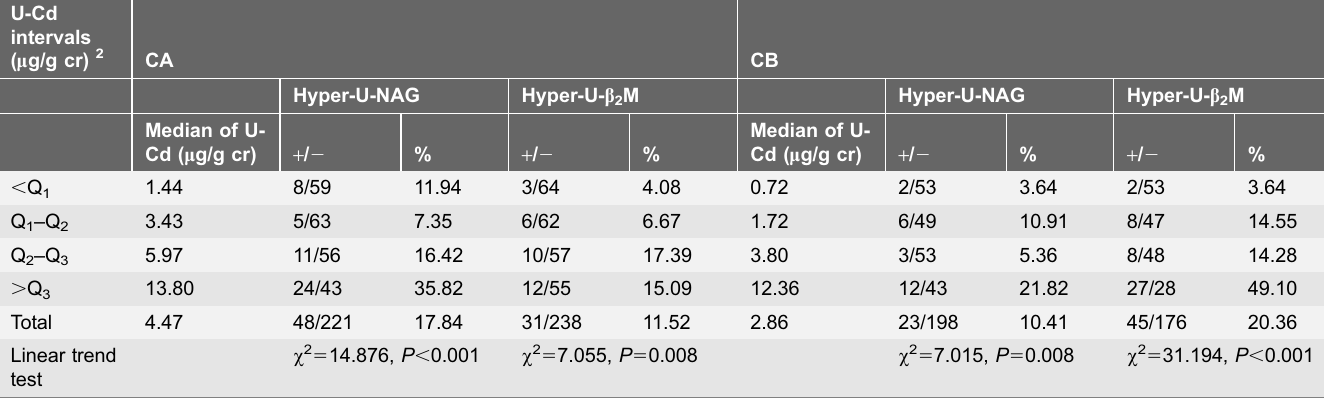
Table 6. Prevalence of hyper-U- b 2 M and hyper-U-NAG corresponding to U-Cd intervals among subjects from county A (CA) and county B (CB) at different cadmium exposure levels 1 . U-Cd